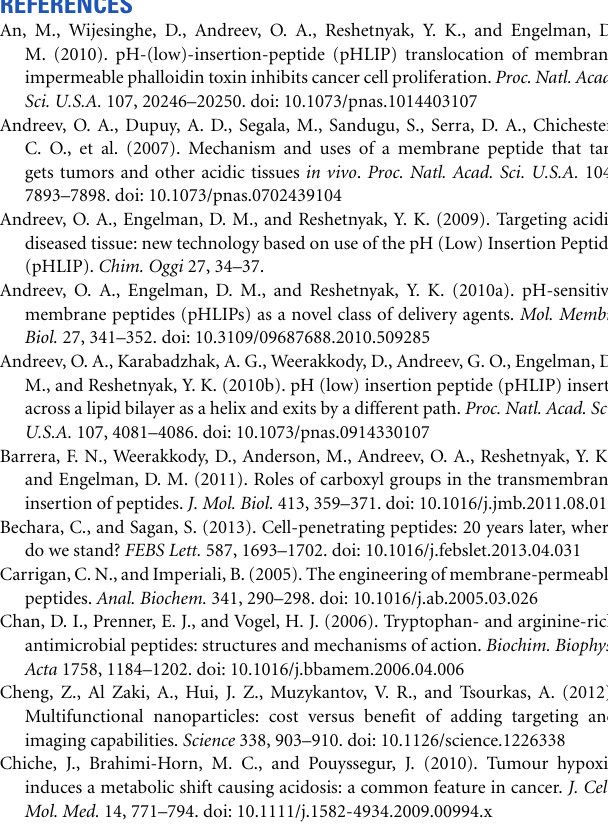
membranes and cytoplasms. The acidity of diseased tissue results in pHLIP-mediated fusion of liposomes with plasma membranes at low extracellular pH (A) or fusion with endosomal membranes (B)